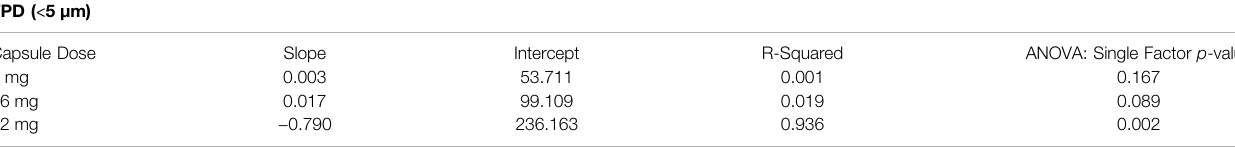
FPD, fi ne particle